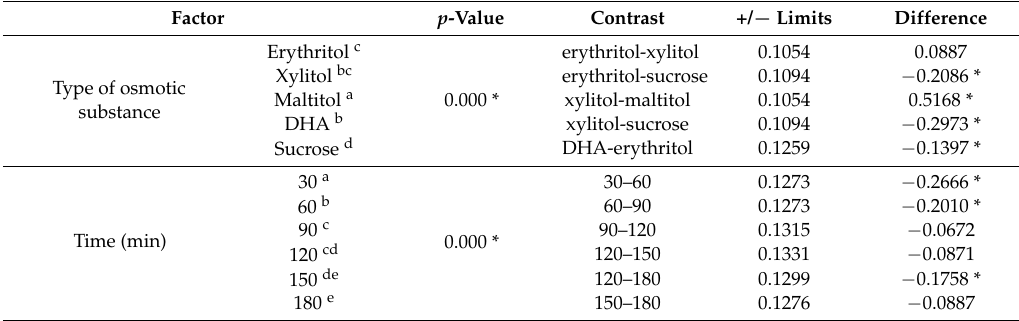
Figure 2. Water loss ( WL ), kinetics using different solutions: erythritol ( ), xylitol ( ● ), maltitol ( ▲ ), dihydroxyacetone ( ♦ ), sucrose ( × ). Lines are the Peleg’s model (solid lines), the Kelvin–Voigt model (dotted lines) and Burgers Model (dashed lines). Table 3. The influence of osmotic agents and pre-treatment time on water loss during osmotic dehydration (OD).